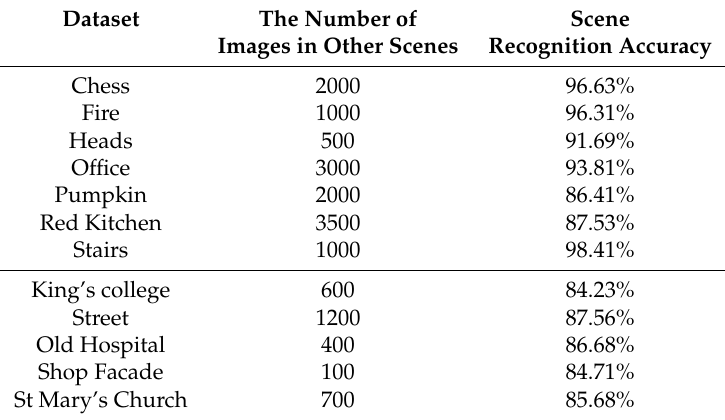
Table 3. The number of images in other scenes added and the accuracy of scene recognition. Dataset The Number of